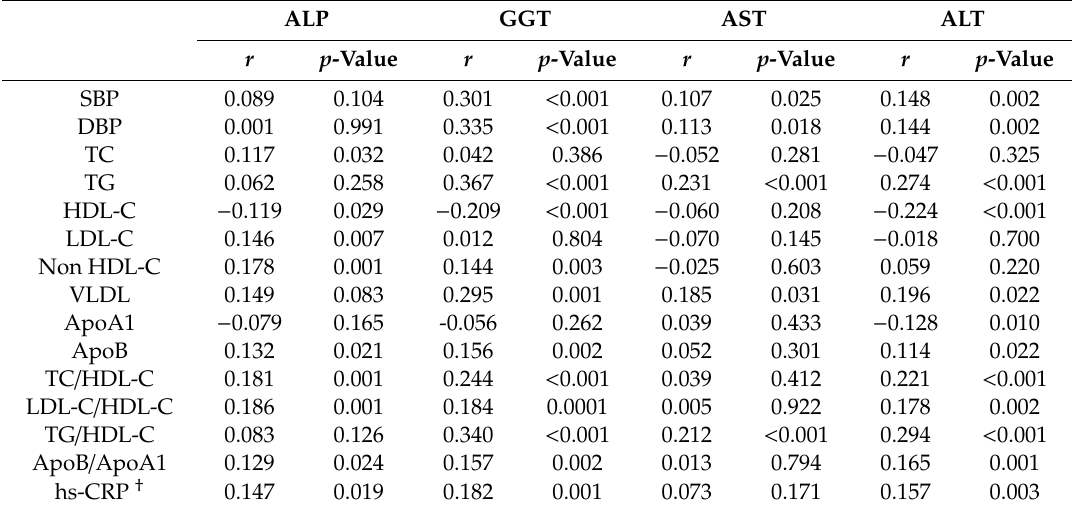
Table 3. Correlation of liver enzymes with cardiovascular risk factors.